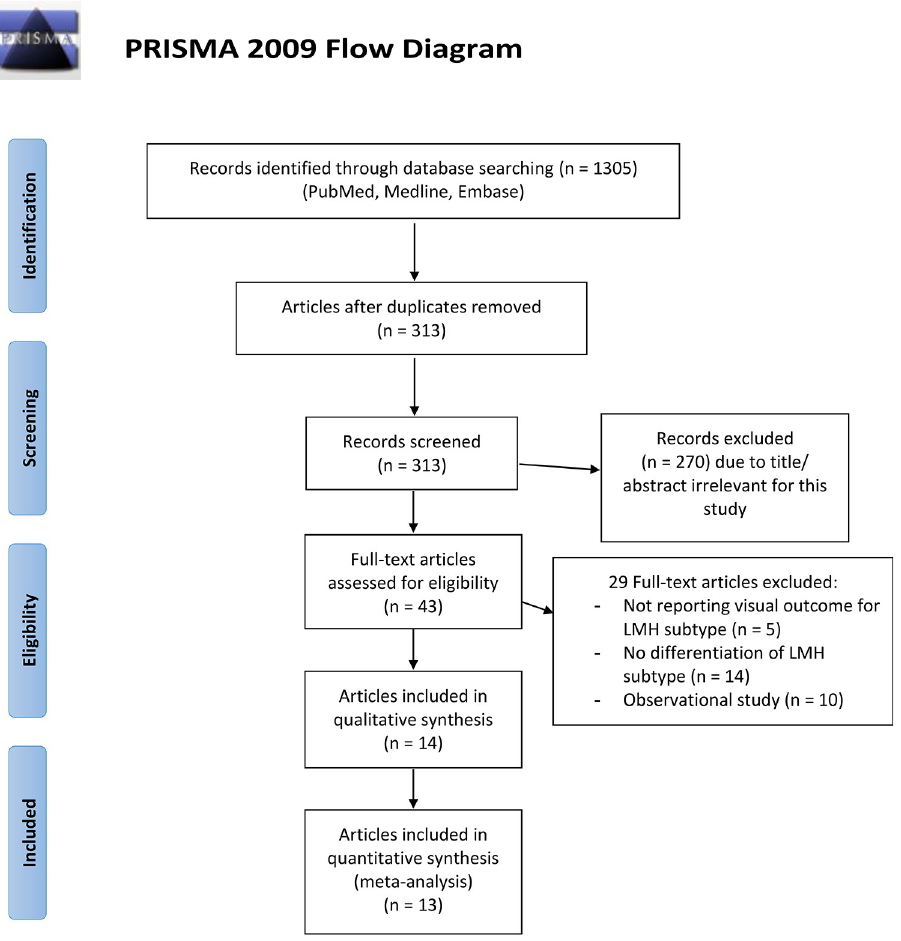
Fig 1. Flow chart of study selection process. From : Moher D, Liberati A, Tetzlaff J, Altman DG, The PRISMA Group (2009). P referred R eporting I terns for S ystematic Reviews and M eta- A nalyses: The PRISMA Statement. PLoS Med 6 (7): e1000097. doi: 10.1371/journal.pmed1000097 For more information, visit www.prisma-statement.org.